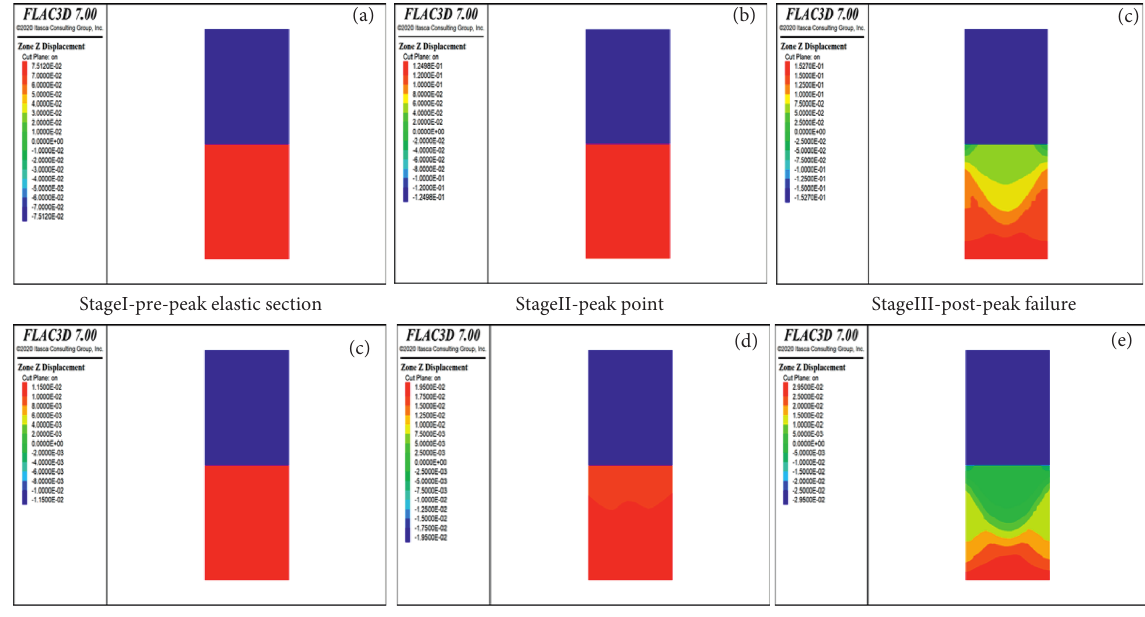
Figure 5: Displacement distribution under different conditions.